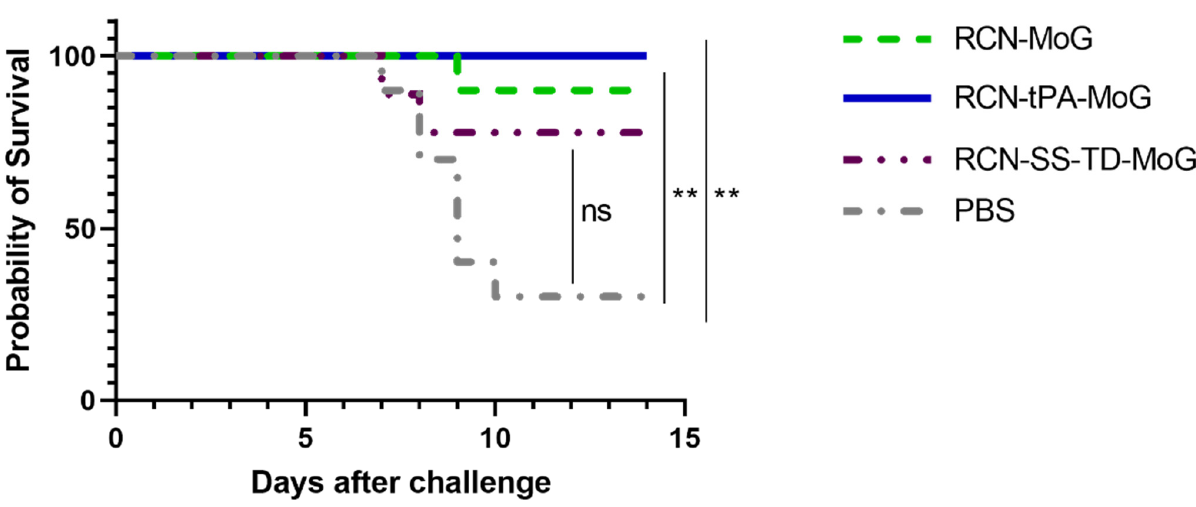
Figure 6. Efficacies of RCN-vectored rabies vaccines in mice after intracerebral challenge with the CVS-11 strain of rabies virus. The RCN-tPA-MoG group had 100% survival from challenge, compared to 90% survival in the RCN-MoG group, 78% in RCN-SS-TD-MoG, and 30% survival in the PBS group. Survival in mice vaccinated with RCN-tPA-MoG and RCN-MoG was significantly higher ( p = 0.0013, p = 0.0061, respectively) than negative controls, but there were no significant differences between vaccine groups and a marginally insignificant difference between the RCN-SS-TD-MoG and control groups ( p = 0.0503). Asterisks on the graph indicate statistical significance (i.e., ** = p ≤ 0.01).